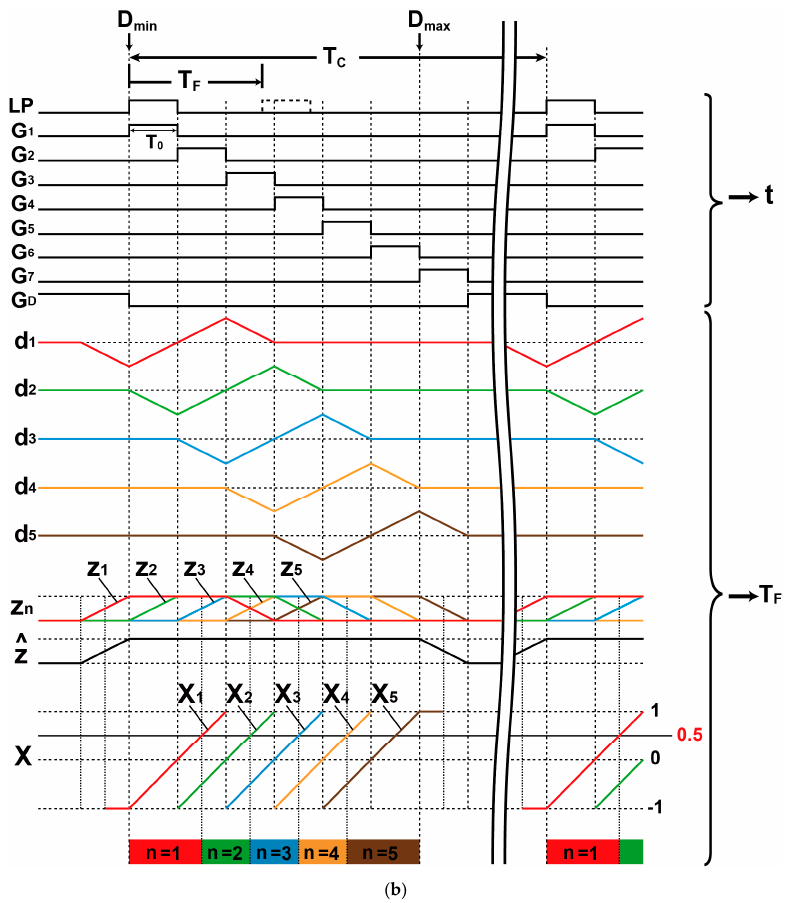
Figure 4. TOF operation of a 7-tap pixel with six time-gating windows: ( a ) principle of a short-pulse TOF measurement system and ( b ) diagram for the distance calculation algorithm.